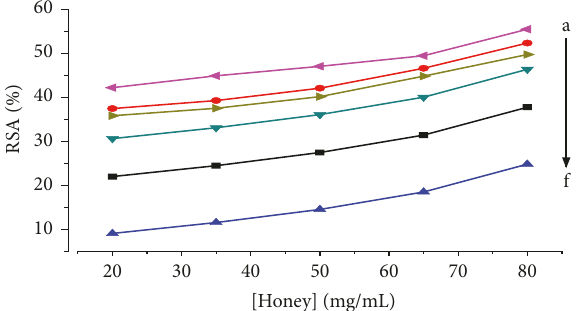
Figure 5: DPPH RSA of the honey samples (a-f: Liben, Burie, R/Azebo, Geregera, Axum, and D/Tembien, respectively) at various concentrations.